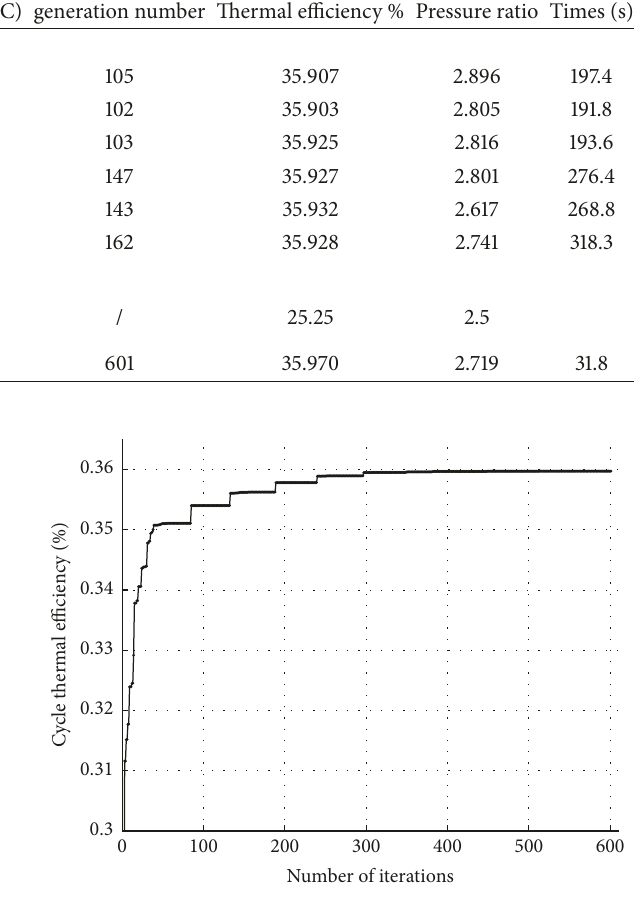
Figure 8: Convergence curve of thermal efficiency with iterations by pattern search